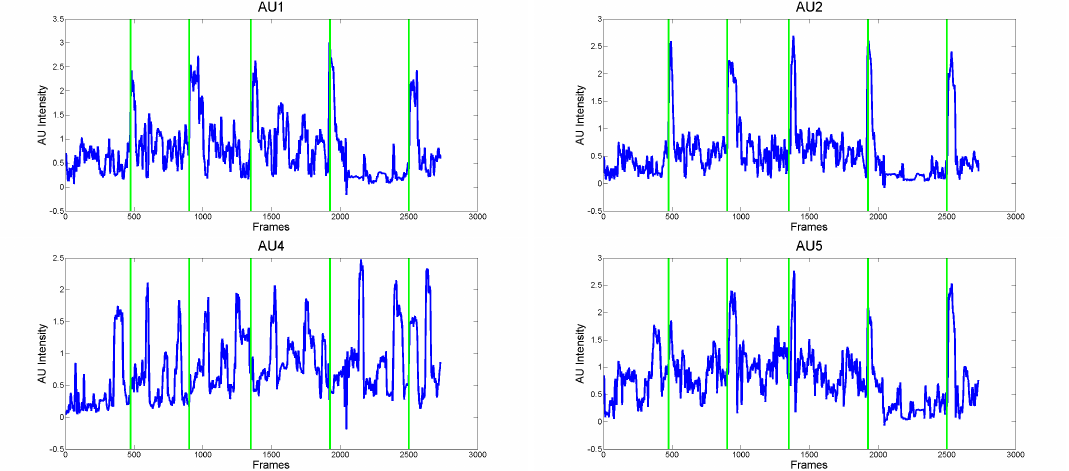
Figure 8. Intensity values computed for Child 2 for the action units involved in the production of the Fear expression and related to the upper face part (from left to right, top to bottom AU1, AU2, AU4 and